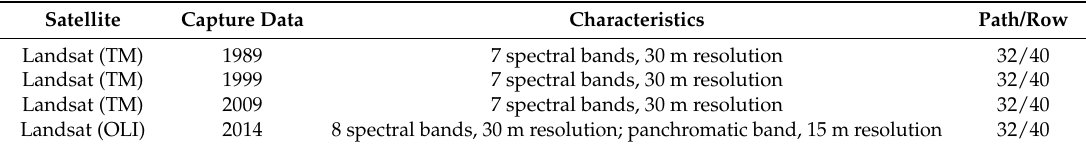
Table 1. Characteristics of the scenes corresponding to the urban and peripheral areas of Chihuahua. Satellite